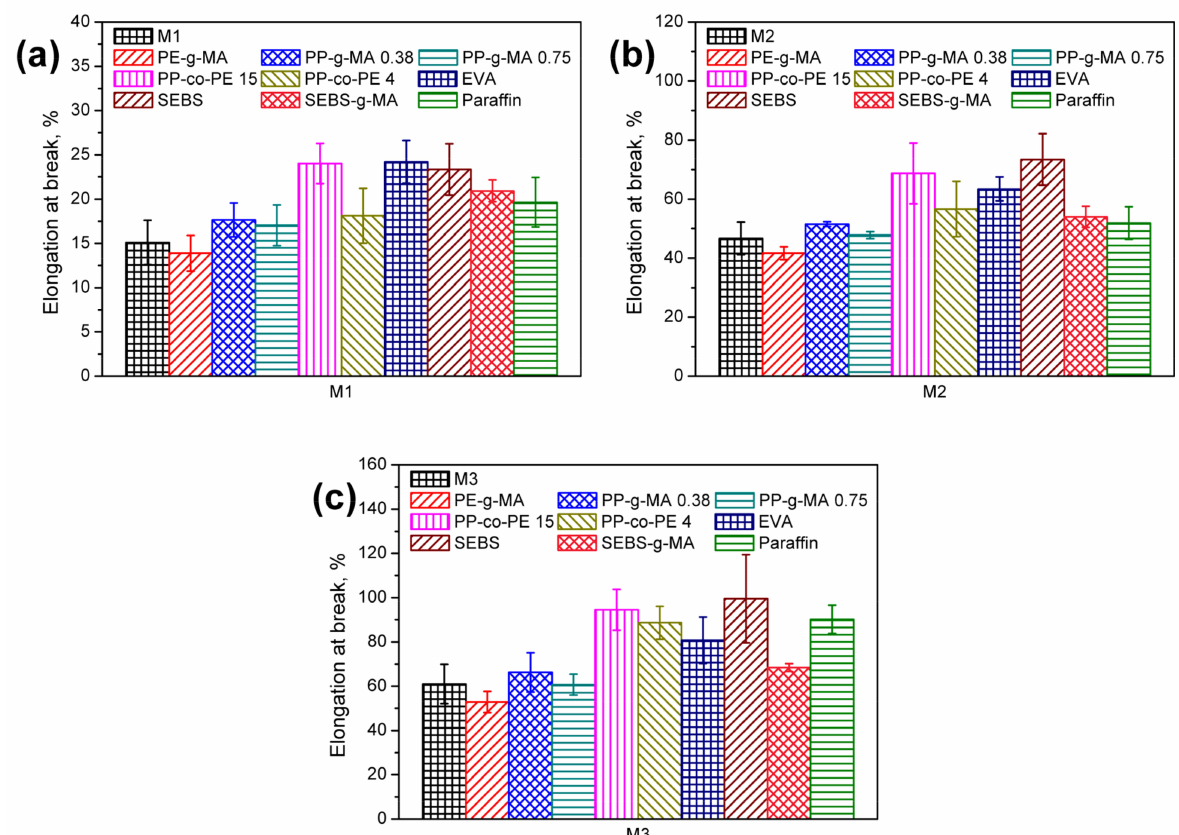
Figure 11. Elongation at break of compatibilized ( a ) M1, ( b ) M2, and ( c ) M3